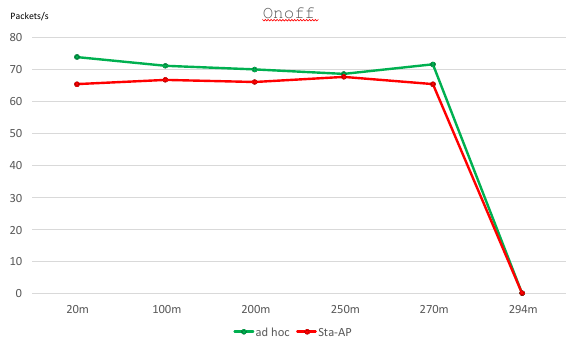
Figure 2. packets/s with different distance.